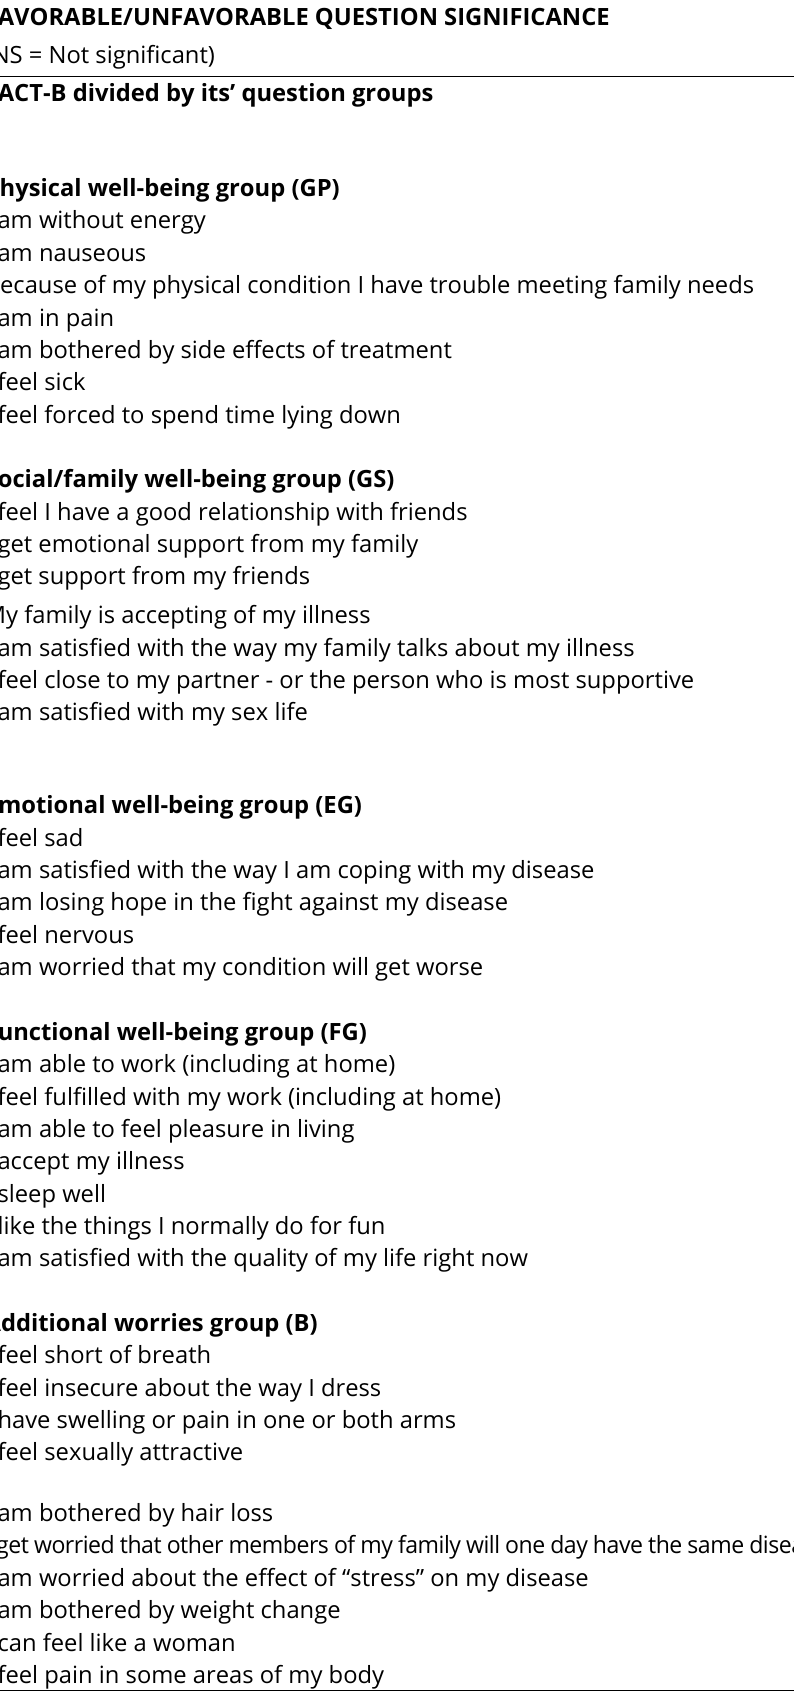
Table 3. FACT-B instrument with its questions and statistical significance levels for each of